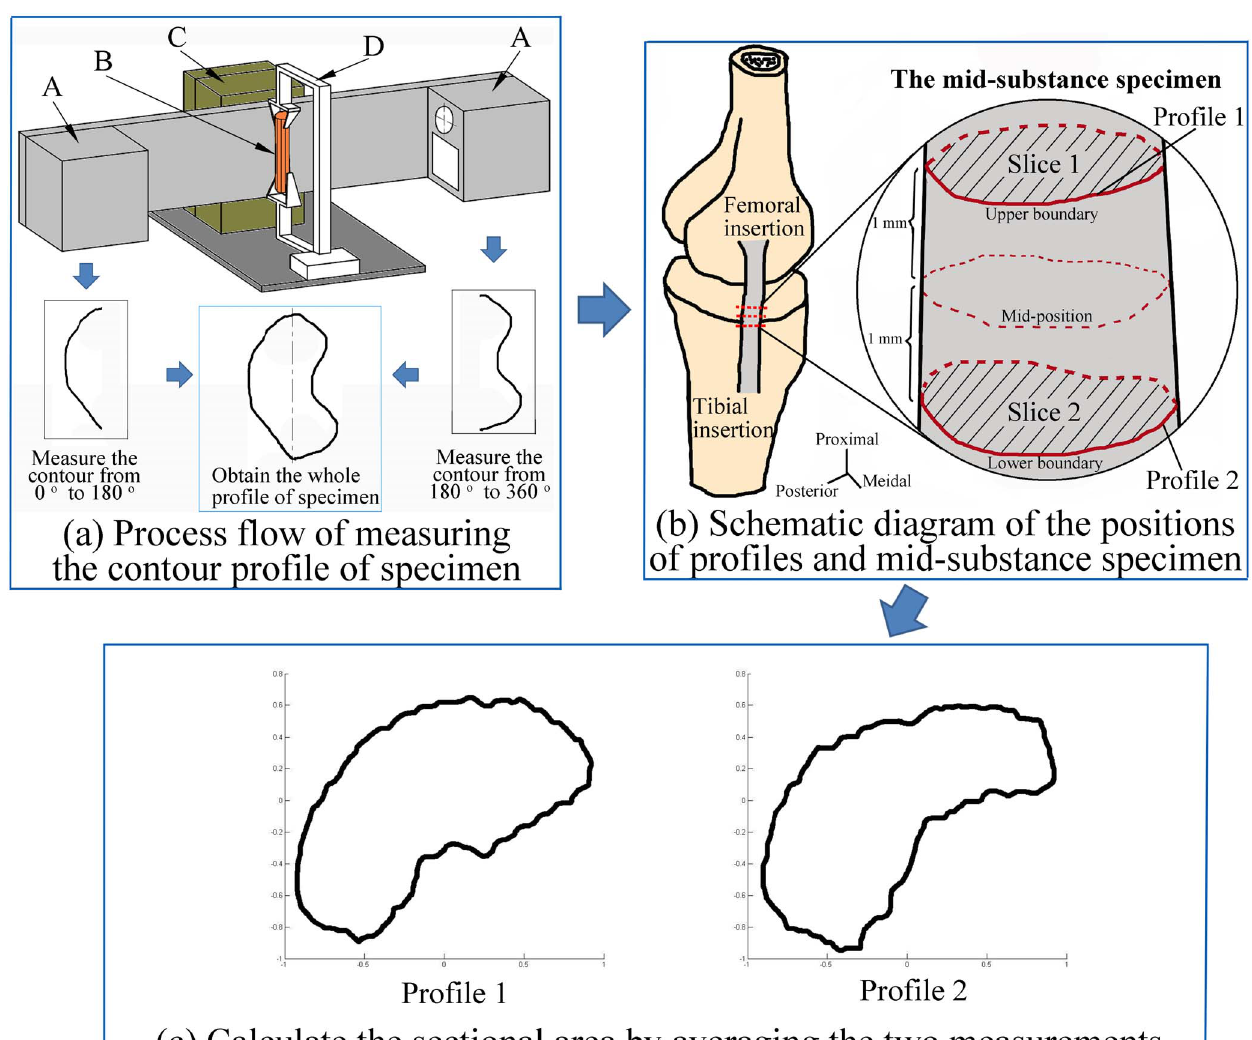
Figure 1. The methodology and devices for measuring the sectional areas of specimens. (a) Bone-ligament-bone samples (B) were fixed by clamps (D) with their longitudinal axes parallel to the direction of the motion unit (C). The contour profiles of the mid-substance specimen between 0–180 degrees and 180–360 degrees were measured by the two opposite sensors (A), respectively. And the whole profile could be obtained by combining the two separate profiles. (b) With the two sensors moving along the direction of the motion unit, two whole profile measurements (i.e., profile 1 & 2) were acquired at the cross sections that were 1 mm far from the mid-position. The mid-position was located at the central section between the femoral and tibial insertions. (c) An average sectional area for each mid-substance specimen was calculated by the two whole contour profiles.